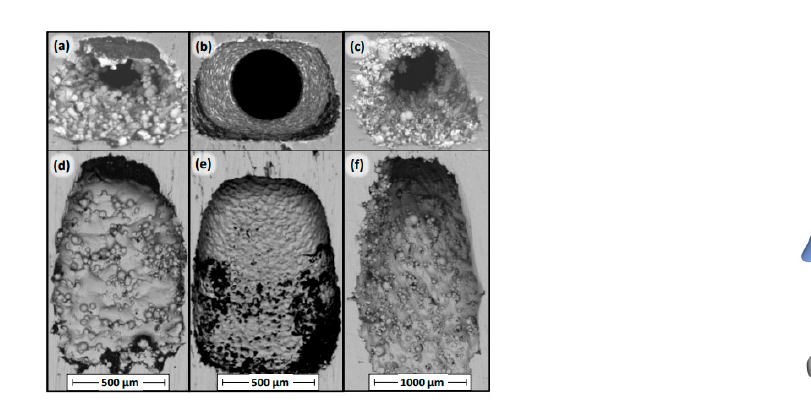
Figure 20. Effect of manufacturing techniques on the film cooling distribution [124]. More discussion is in [116].